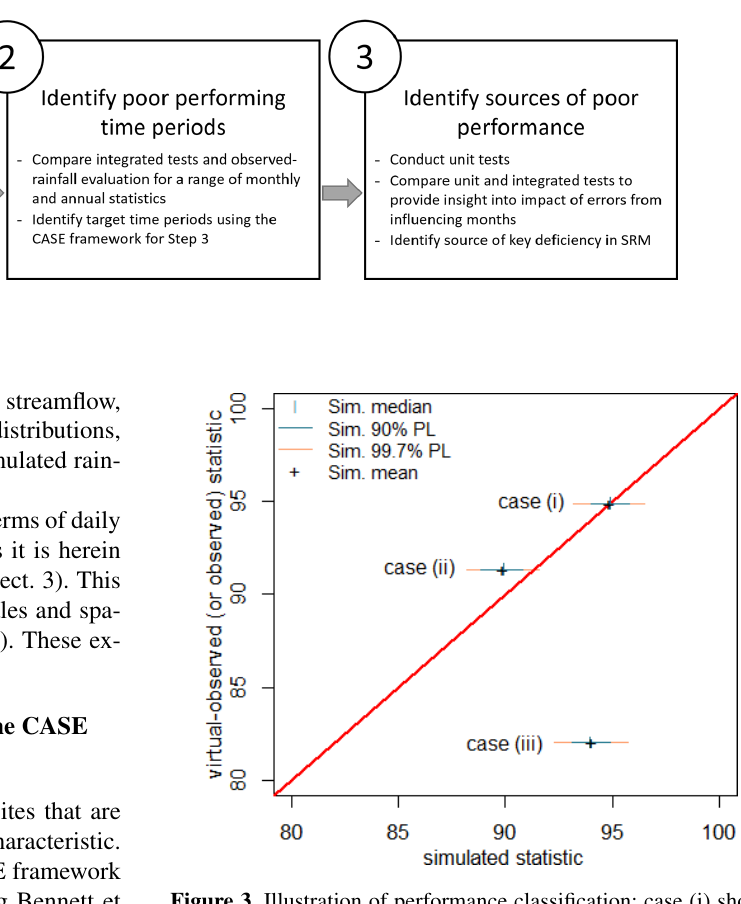
Figure 3. Illustration of performance classification: case (i) shows “good” performance, case (ii) shows “fair” performance, and case (iii) shows “poor” performance. Adapted from Bennett et al.